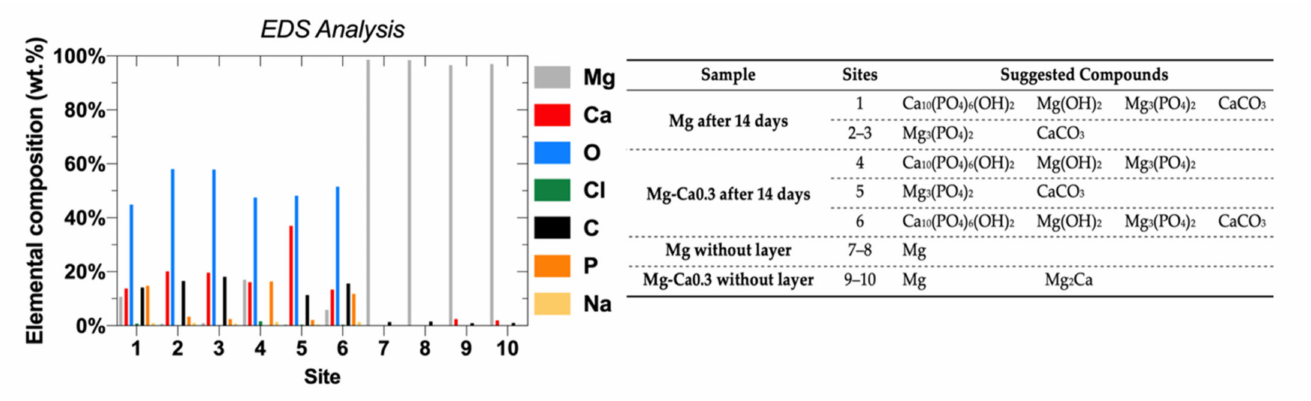
Figure 4. EDS analysis of corresponding sites marked in the SEM images (Figure 3A,B,E,F) and suggested compounds, formed before and after removal of the surface